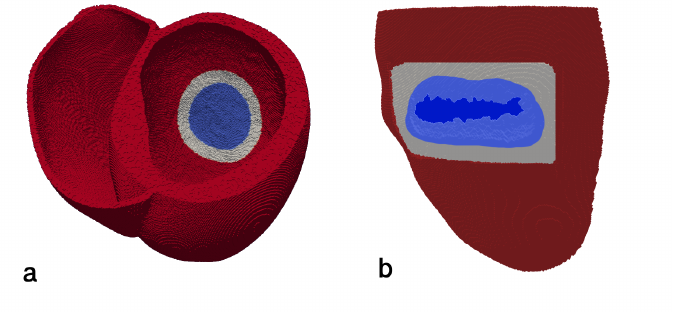
Figure 2. View of the post-infarction scars (blue) and gray zone (gray) around it. Healthy area is shown in red. ( a ) Post-infarction scar and gray zone has an ideal circular shape. Radius of the scar is 18 mm (perimeter of 114 mm), width of the border zone is 5 mm. There are 381612 points for healthy tissue, 8109 points for the gray zone tissue, and 15661 points for the scar tissue. ( b ) Post-infarction scar of realistic shape derived from a CT clinical infarction image. There are 161783 points on the image. (The image was generated by the authors from open data source from the file 1-mesh-uvc.vtk which can be found at https://doi.org/10.18742/RDM01-570, (accessed on 13 August 2021) in a supplement for the paper in [18]). The scar perimeter is 72 mm and gray zone width is 7.5 mm. Light blue color displays the scar on the epicardial surface and dark blue color displays the scar on the endocardial